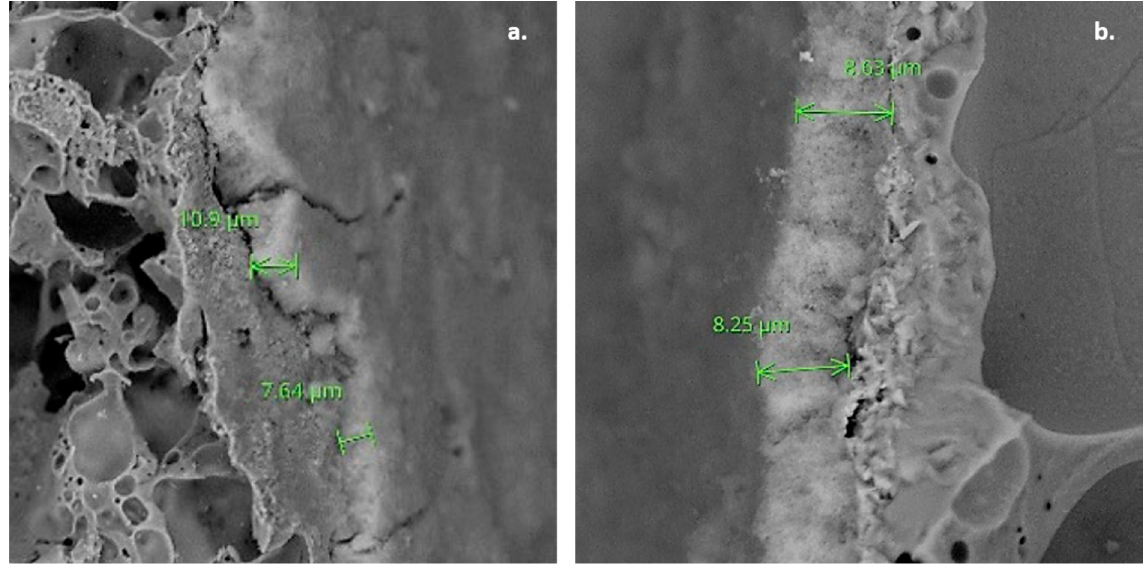
Figure 9. TiO 2 layer thickness measurement through SEM for the different TiO 2 loads, ( a ) 3.6% w / w and ( b ) 5% w / w